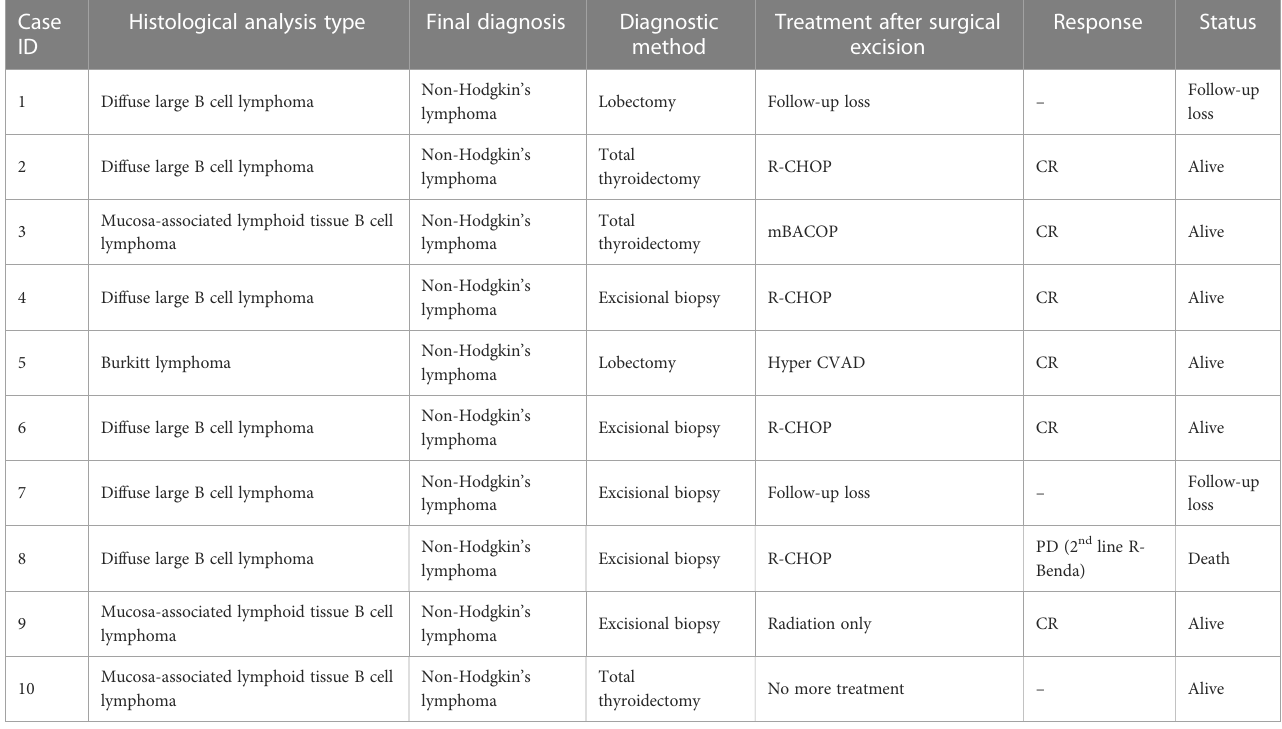
TABLE 2 Patients ’ histological types and clinical